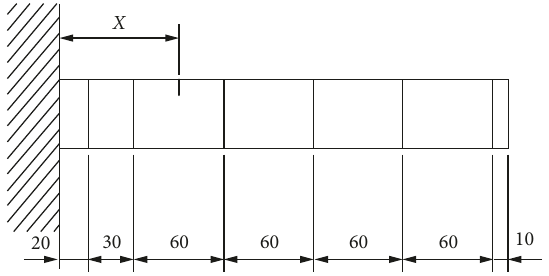
Figure 3: Finite element model of the cracked cantilever beam for obtaining natural